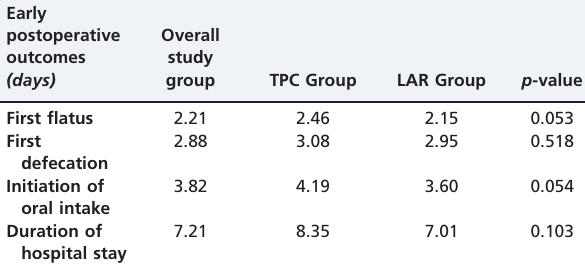
Table 3 - A comparison and statistical analysis of the association between the presence of a remnant colon and the early postoperative outcomes, using independent samples student’s t